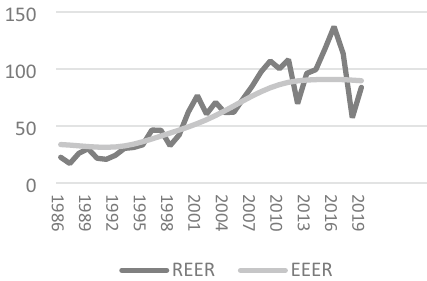
Fig. 1 Equilibrium and real effective exchange rate